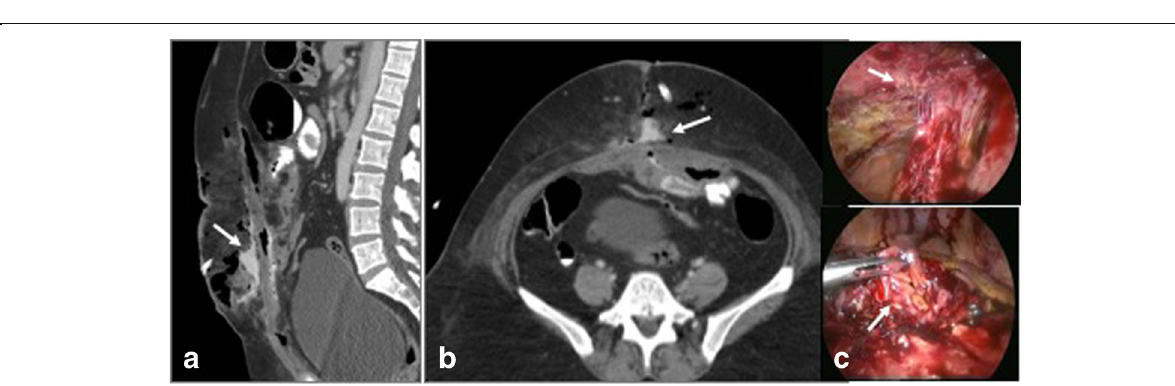
Fig. 13 a , b CECT with oral positive contrast in a post ventral hernia repair shows small bowel fistulous communication showing extravasation of oral contrast through exterior (arrows). c Per operative demonstration of small bowel perforation and extensive adhesions